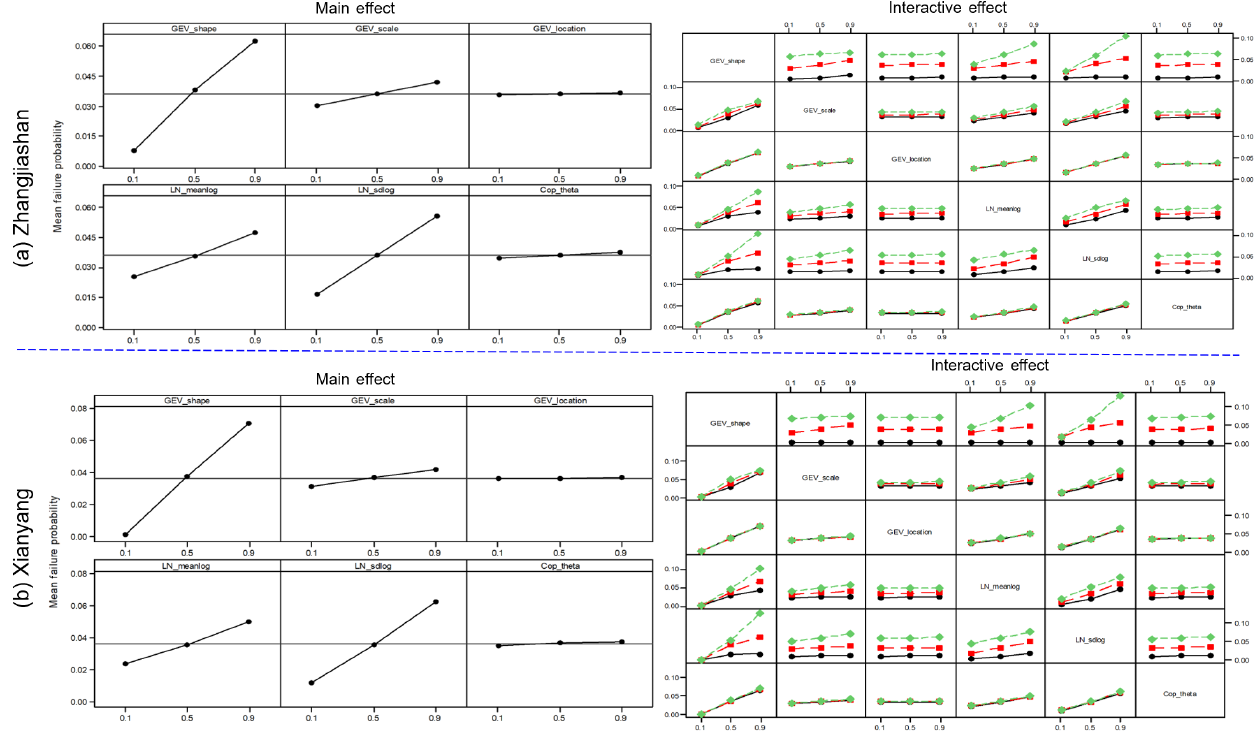
Figure 7. Main effects plot and full interactions plot matrix for parameters on the failure probability in AND at the two gauge stations.